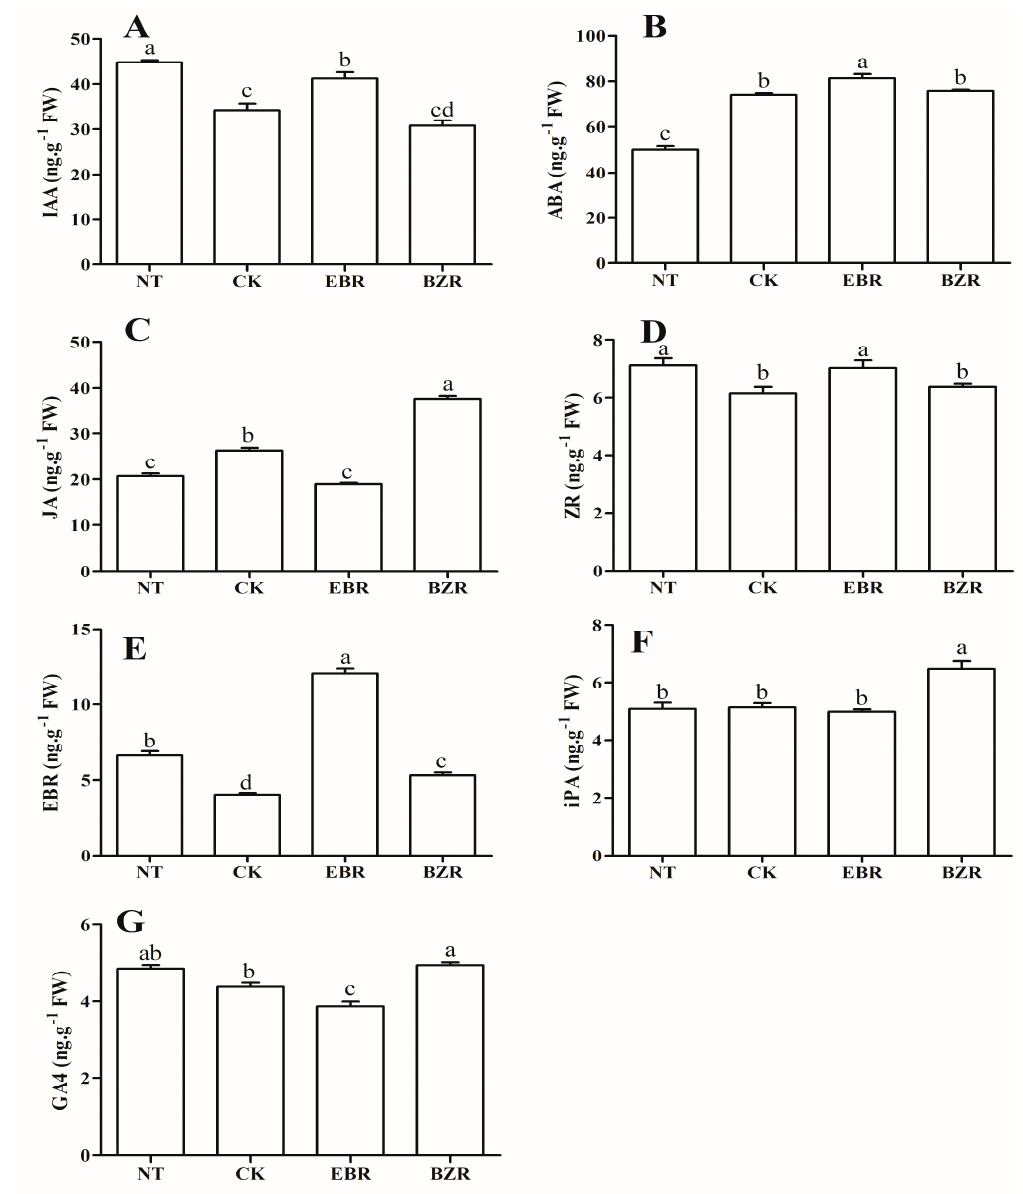
Figure 4. Effect of EBR on endogenous hormone regulation under low-temperature stress in cucumber seedlings. ( A ) Indol-3-acetic acid (IAA); ( B ) Ascorbic acid (ABA); ( C ) Jasmonic acid (JA); ( D ) Zeatin riboside (ZR); ( E ) Brassinosteroid (EBR); ( F ) Isopentenyl adenosine (iPA); ( G ) Gibberellin A4 (GA4). Different letters indicate significant differences at p < 0.05.